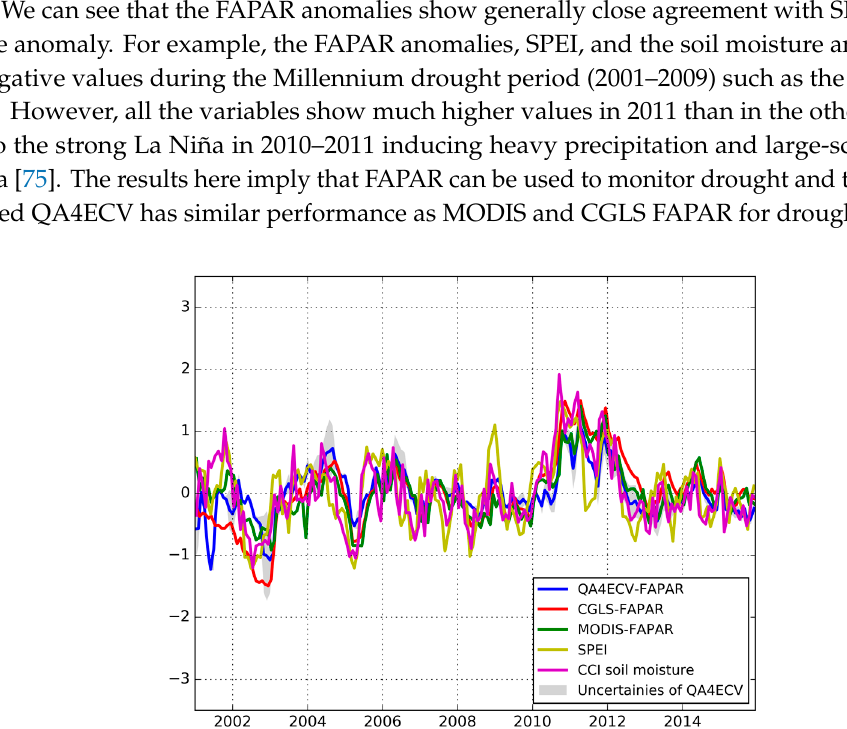
Figure 7. Temporal variation of area means of SPEI, standardized anomalies of analyzed FAPAR products, and the soil moisture anomaly for the period of 2001 to 2015. It is noted that the grey areas are the uncertainties of QA4ECV FAPAR.